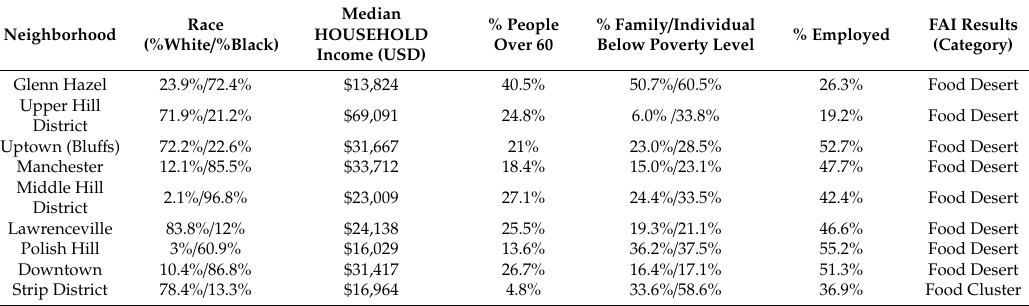
Table 1. Neighborhood demographics and Food Abundance Index (FAI)